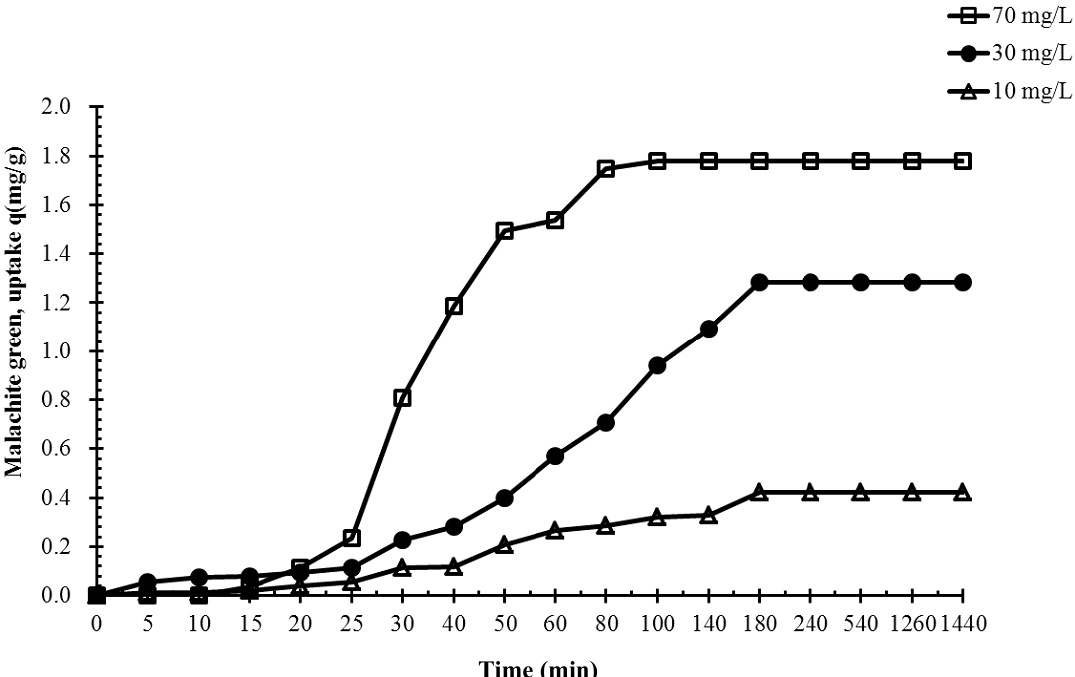
Figure 4. Effects of initial dye concentration on the biosorption of the malachite green dye by immobilized cells of P. sanguineus (temperature: approximately 25